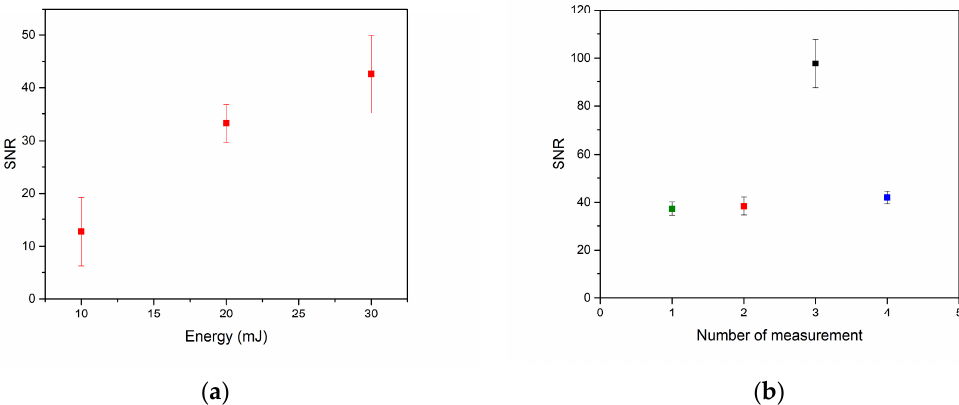
Figure 4. ( a ) SNR dependence on energy for zinc spectral line 334.50 nm; ( b ) SNR dependence on ambient atmosphere (green—analyzed in air purge on 12 July 2019, red—analyzed in air purge on 23 September 2019, black—argon purge, blue—argon atmosphere).